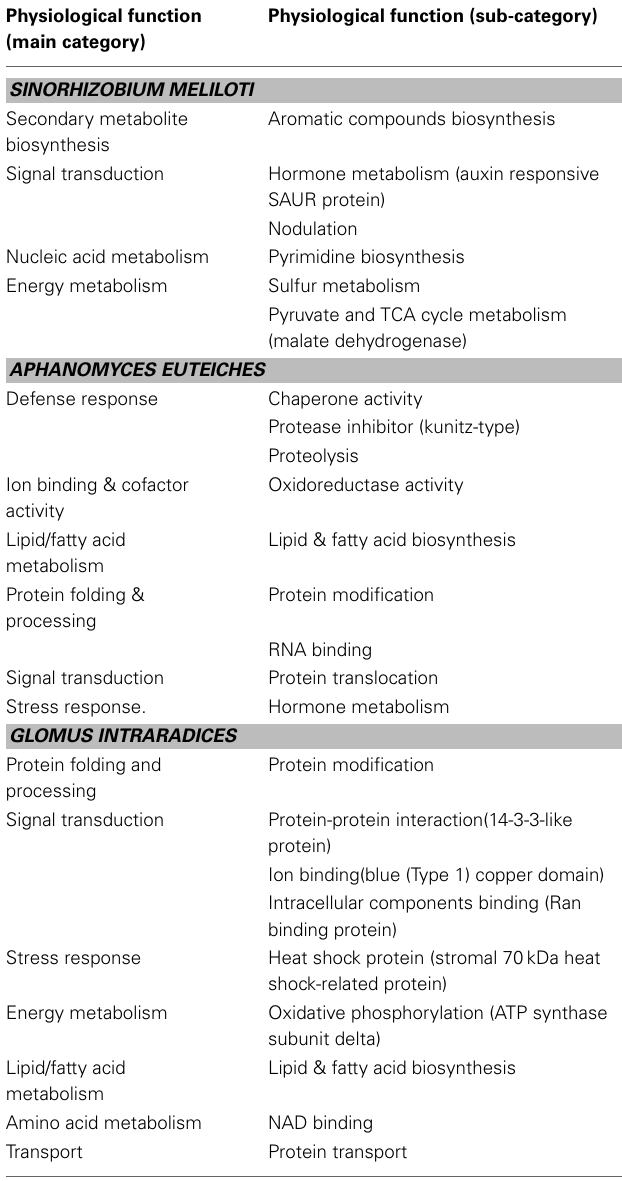
Table 1 | Protein categories induced only in specific